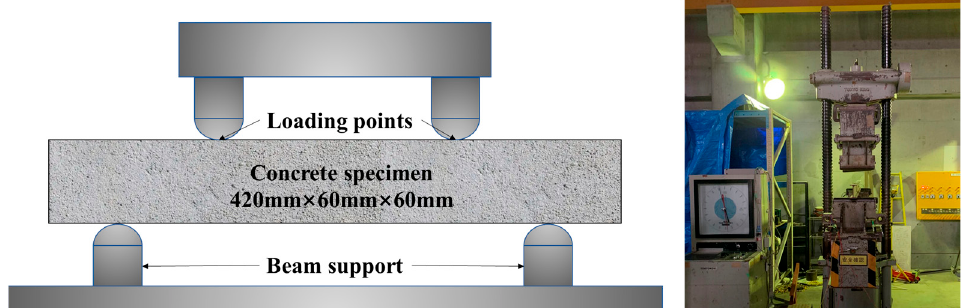
Figure 7. Schematic diagram of concrete specimen and four-point bending test .